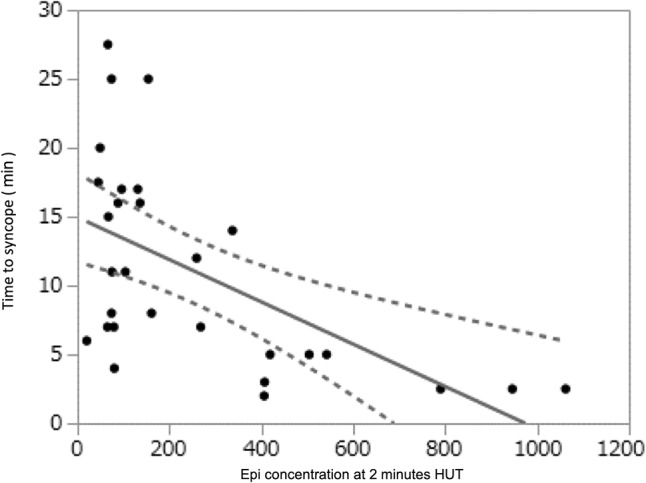
Data derived from Kohno et al. (19) showing that the time to syncope during HUT was shorter (Time in Minutes on ordinate) as the Epi concentration increased (abscissa, pg/ml).